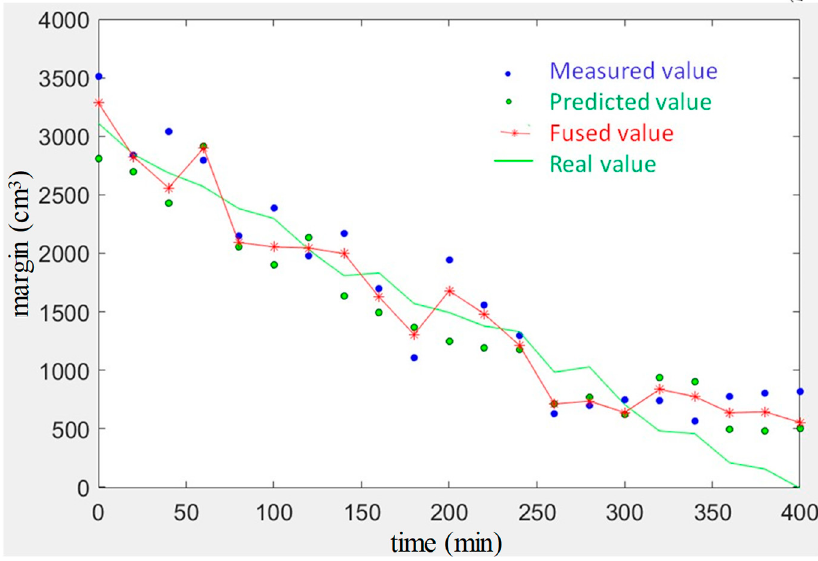
Figure 16. Kalman filter effect.